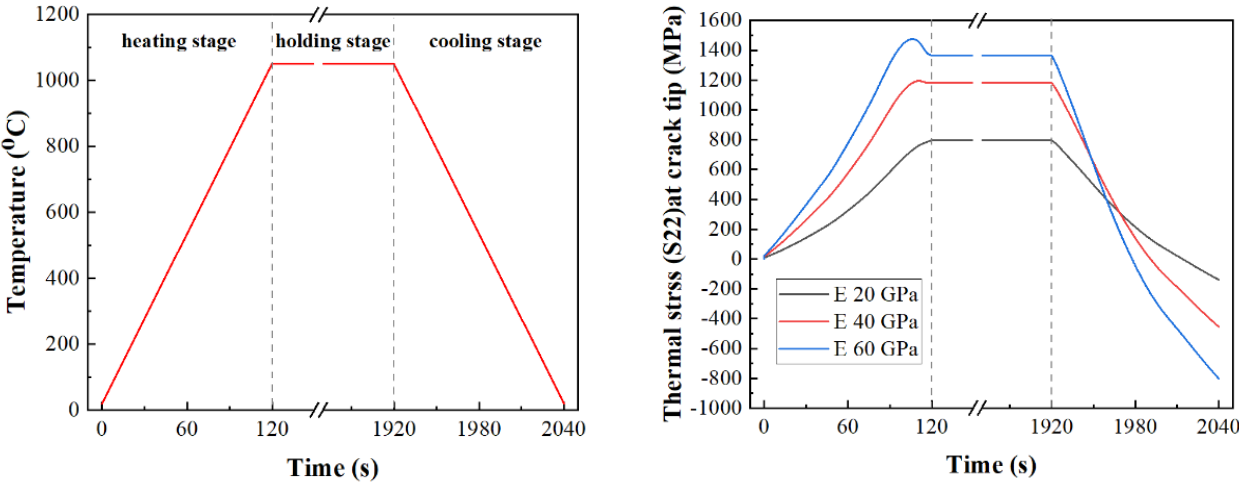
Figure 15. Evolution of stress S22 at the crack tip in the coating during thermal cycling. In this simulation, the stress state of the coating during thermal shock was studied by elastic-plastic analysis, and the effect of elastic modulus of ceramic layer on the crack tip stress of the coating was investigated. The results show that reducing the elastic mod- ulus of the ceramic coating plays a very significant role in alleviating the crack driving force in the coating. From the difference of porosity and hardness, it can be seen that the coating prepared by coarse particle size YSZ has lower elastic modulus than the coating prepared by fine particle size YSZ, so the coating bears less thermal stress at the crack tip during thermal shock. 3.5. Thermal Shock Resistant Analysis of Coating The cracking behavior of TBCs during thermal shock depends on two factors; the cracking resistance of the coating itself and the cracking driving force formed during ther- mal shock. The porosity of the coating will affect its fracture toughness and strain toler- ance. With the change of porosity, the fracture toughness and strain tolerance often change in the opposite direction, that is, when the fracture toughness of the coating increases by reducing the porosity, the strain tolerance of the coating will become worse. Considering the crack evolution behavior, porosity and mechanical properties of the coating during thermal shock, the effect of YSZ powder particle size on the thermal shock failure of the two coatings can be clarified. Although the porosity of the coating prepared by fine YSZ is small and the coating has relatively high fracture toughness, the strain tolerance of this coating is worse than that of the coating prepared by coarse YSZ. Therefore, the crack tip of the coating prepared by coarse YSZ is driven by greater cracking force during thermal shock. Since the adverse effect of the decrease of strain tolerance caused by low porosity of the coating prepared by fine YSZ is more significant than that on the improvement of fracture toughness of the coating, so the crack in the coating propagates at a faster rate during thermal shock, and the coating shows a shorter thermal shock life. In addition, the pore size of the coating prepared by fine YSZ is smaller. These smaller pores are easier to be sintered at high temperature, resulting in a further reduction of the strain tolerance of the coating. Therefore, with the increase of thermal shock cycle, the cracking driving force of the crack tip in the coating becomes larger and larger. However, the pore size of the coating prepared by coarse YSZ is larger, and there are still many pores that cannot be sintered after thermal shock, which restrain the strain tolerance degrada- tion of the coating to a certain extent. The study of Rad et al. [40] shows that the pores in the ceramic layer will significantly affect the stress distribution in the coating. The dis- persed pores can alleviate stress concentration in the coating. In this experiment, the